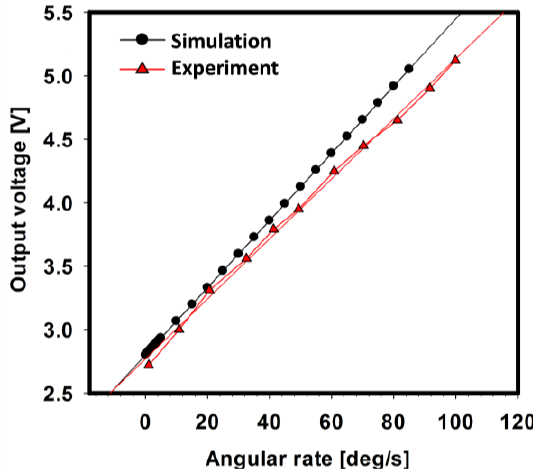
Figure 10. Comparison of the scale factor between the simulation and experiment.